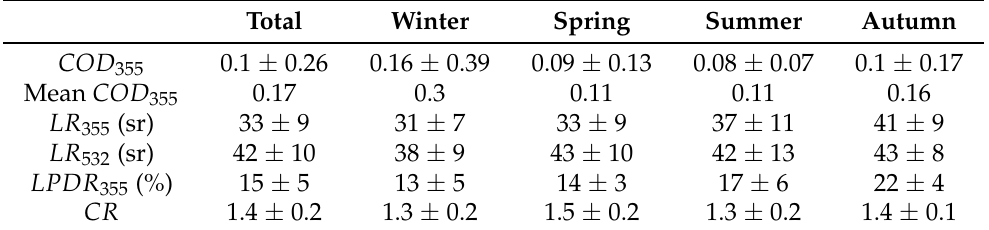
Table A3. Total and seasonal descriptive statistics of cirrus layer optical properties for the high COD regime